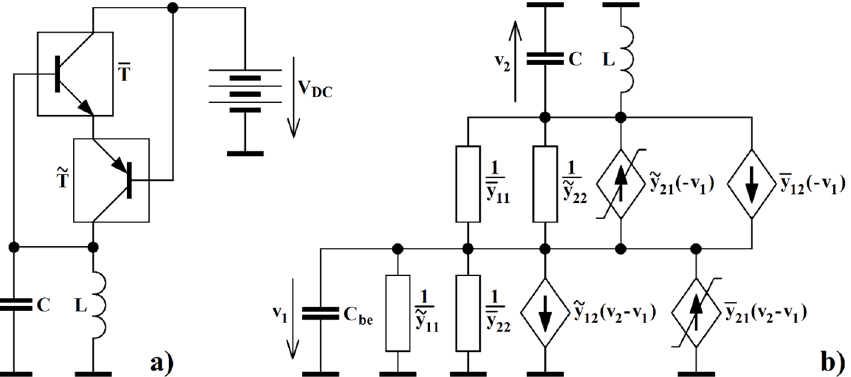
Figure 1. Negative resistance oscillator with the lambda diode: ( a ) principal schematic with generalized bipolar transistors, ( b ) equivalent small-signal model with nonlinear voltage controlled current sources.